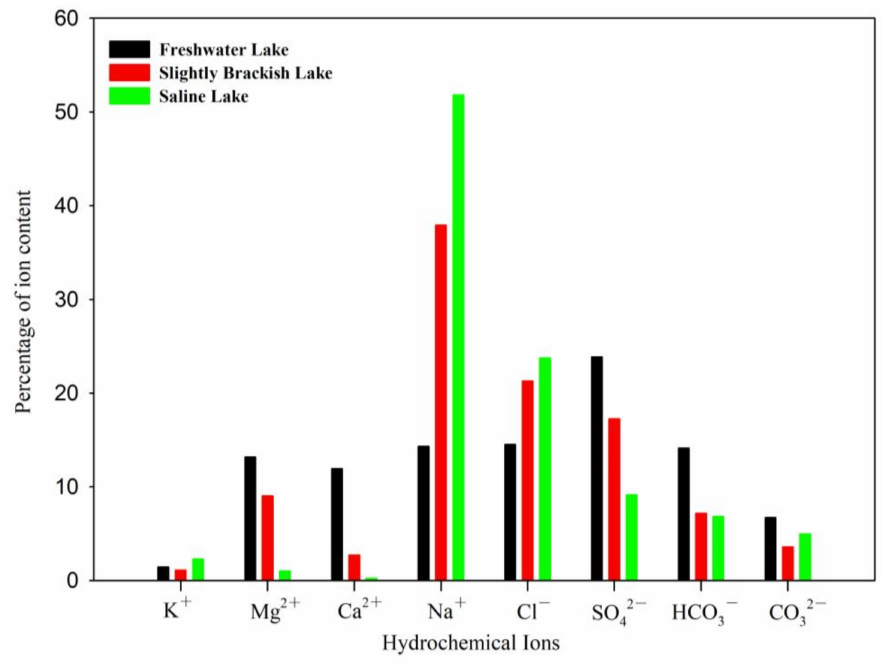
Figure 2. Ion concentrations (in meq) in individual types of